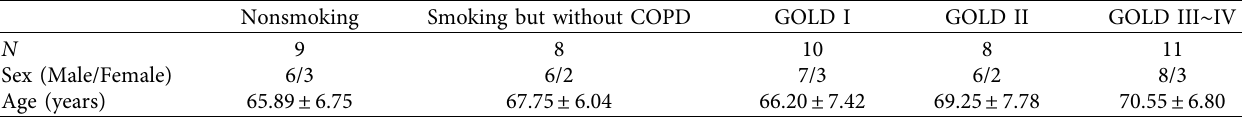
Table 1: Basic information of different